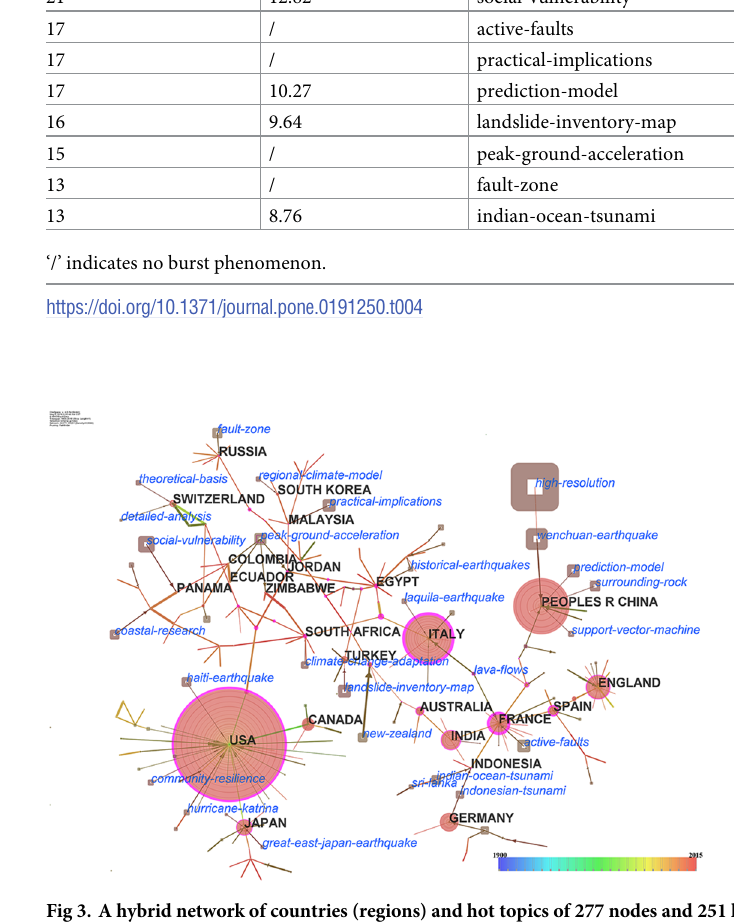
Fig 3. A hybrid network of countries (regions) and hot topics of 277 nodes and 251 links. Circular nodes represent countries/regions. Square nodes represent topics. The color of the ring of a circle are corresponding to the year. The size of a circle is in proportion to the number of literatures of the country. The size of a square is in proportion to the frequency of the topic. The purple rims of nodes represent the high betweenness centralities.